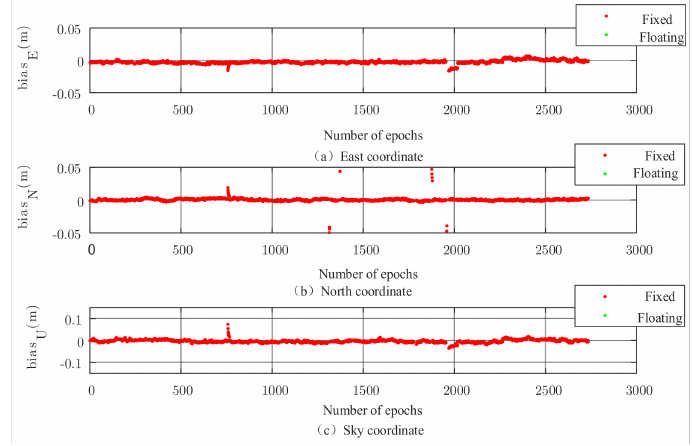
Figure 9. Three-dimensional baseline solution of the combined optimization algorithm.